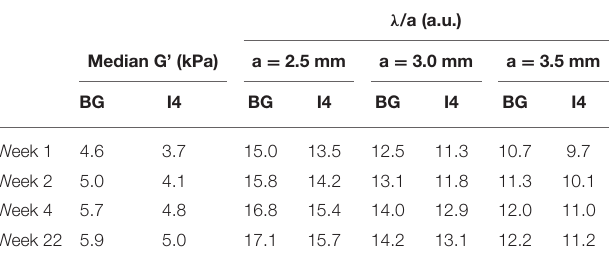
TABLE 4 | Measured G’ in the largest inclusion (I4, softener composition S2.1) and background (BG, softener composition S1.9) at 3-mm resolution for different time elapsed since fabrication and corresponding estimated ratio of wavelength to voxel size λ /a for the considered voxel sizes a . λ /a